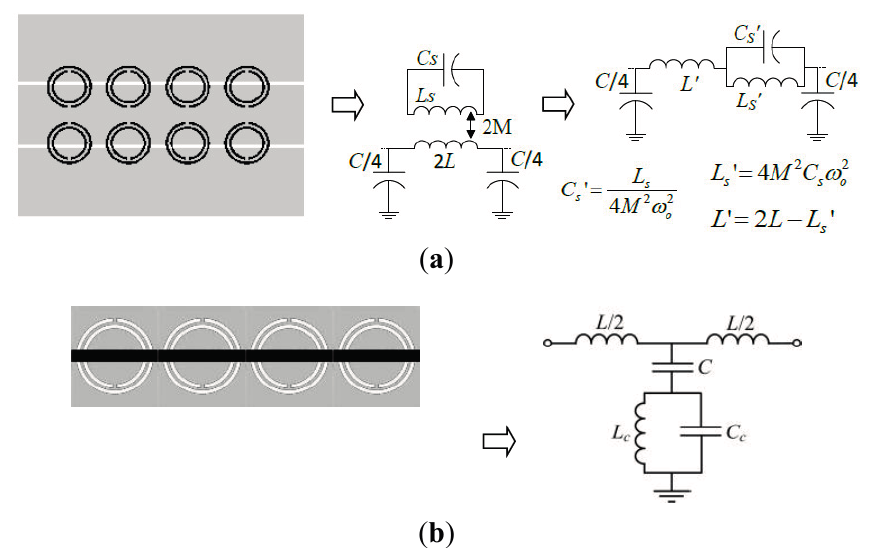
Figure 2. Typical layout and circuit model (unit cell) of an SRR-loaded line ( a ) and CSRR-loaded line ( b ). In (a), the magnetic wall concept is applied. L and C represent the per-section transmission line inductance and capacitance, respectively, C s - L s and C c - L c are the capacitance-inductance of the SRR and CSRR, respectively and M is the mutual inductance between the SRRs and the line. In (a), the circuit model can be transformed to the one in the right hand side, with the indicated